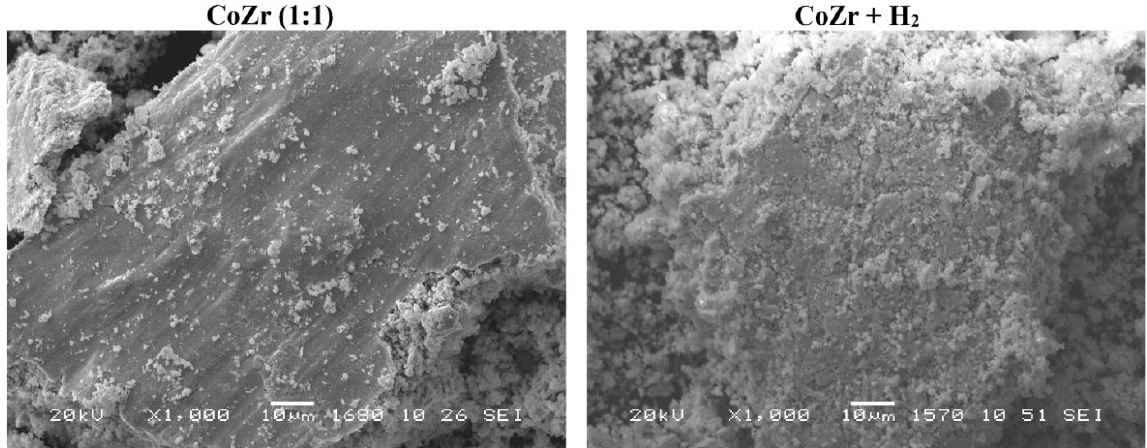
Figure 10. SEM images of the Co-Zr mechanical alloying product particles in contact with the ball mill shell before ( left ) and after ( right ) high-pressure hydrogen treatment.